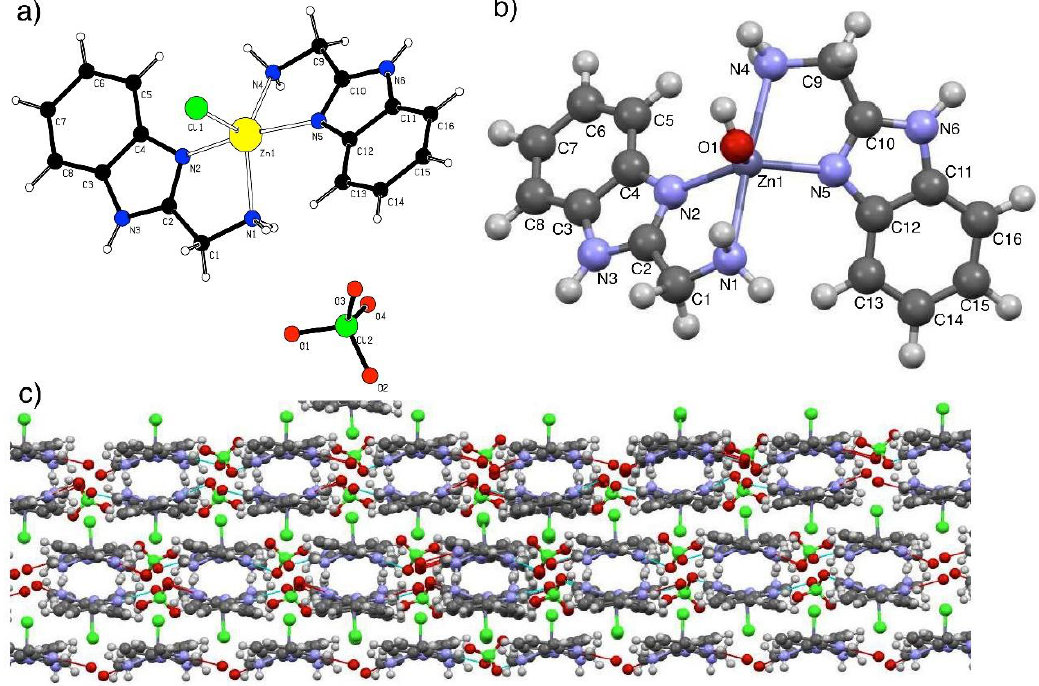
Figure 1. ( a ) ORTEP structure of complex 1 , ( b ) numbered DFT optimized structure of complex 2 and ( c ) 2D packing model of complex 1 along the a-axis showing the hydrogen bond network.